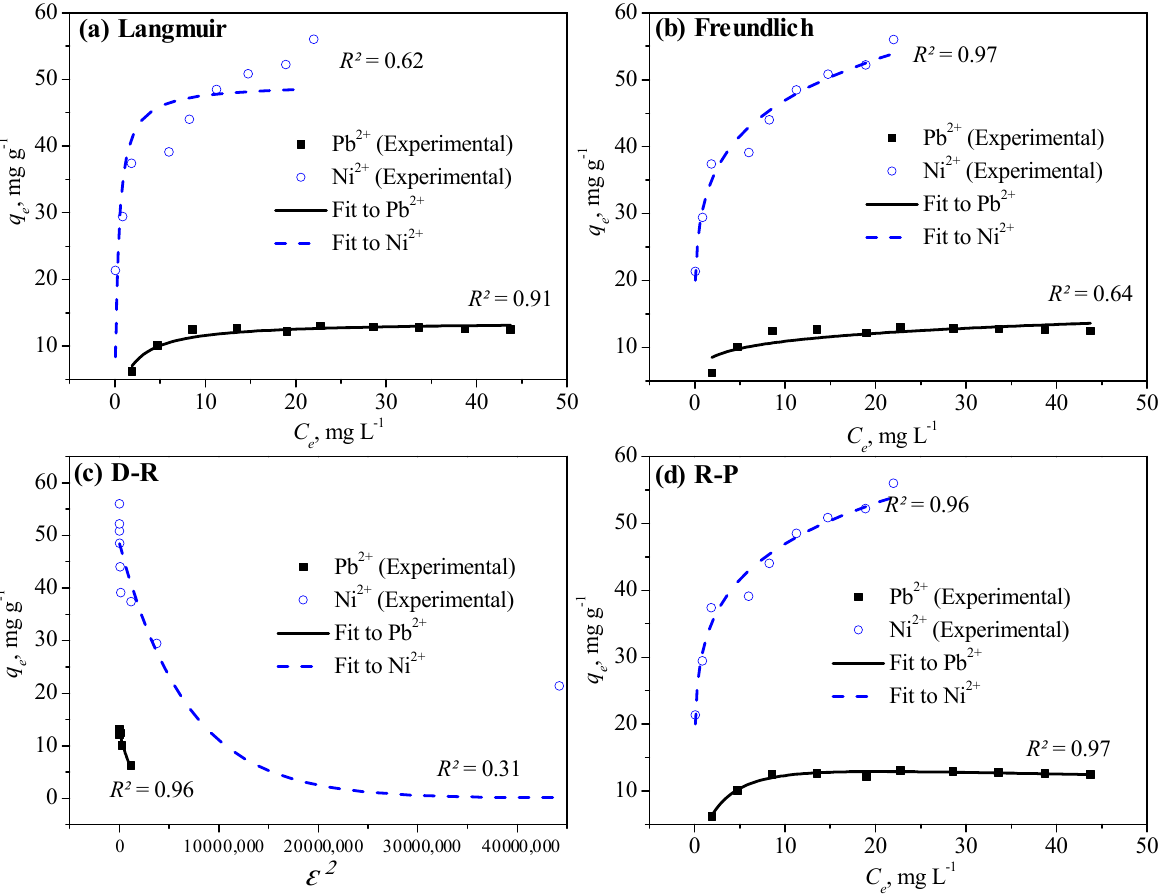
Figure 6. Nonlinear and linearized fitting of ( a ) Langmuir, ( b ) Freundlich, ( c ) Dubinin–Radushkevich (D–R), and ( d ) Redlich–Peterson (R–P) to the adsorption data of Pb 2+ and Ni 2+ onto PANmod.